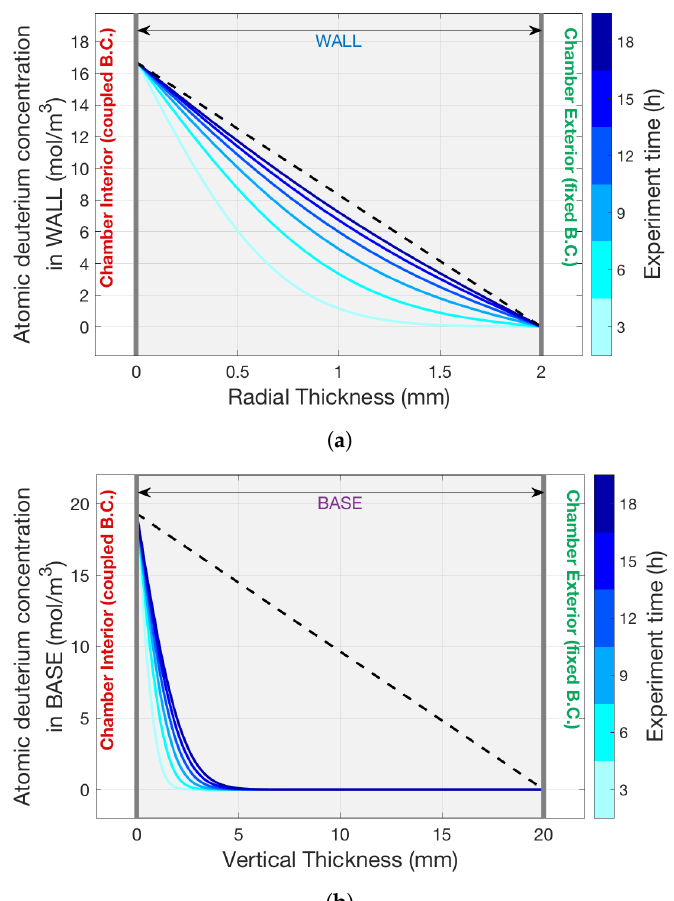
Figure 6. Simulation of concentration profiles evolution during 18 hours in the WALL and BASE steel media, using avg dissolution parameters ( vide Table 1). Initial gas pressure set to 780 mbar and BASE temperature set to 450 ◦ C, to be representative of experiments performed with the heater set at that temperature. The difference in medium thickness (of one order of magnitude) leads to steeper concentration gradients that ensure the profile evolves faster in the WALL than in the BASE, in spite of the WALL having a lower average temperature ( ≈ 405 ◦ C). Profiles tend towards pseudo-steady- state (PSS; dashed lines), which represent the expected steady-state profiles computed using the BCs of the last time step. ( a ) Concentration profile evolution in the WALL. Medium thickness of 2mm. ( b ) Concentration profile evolution in the BASE. Medium thickness of